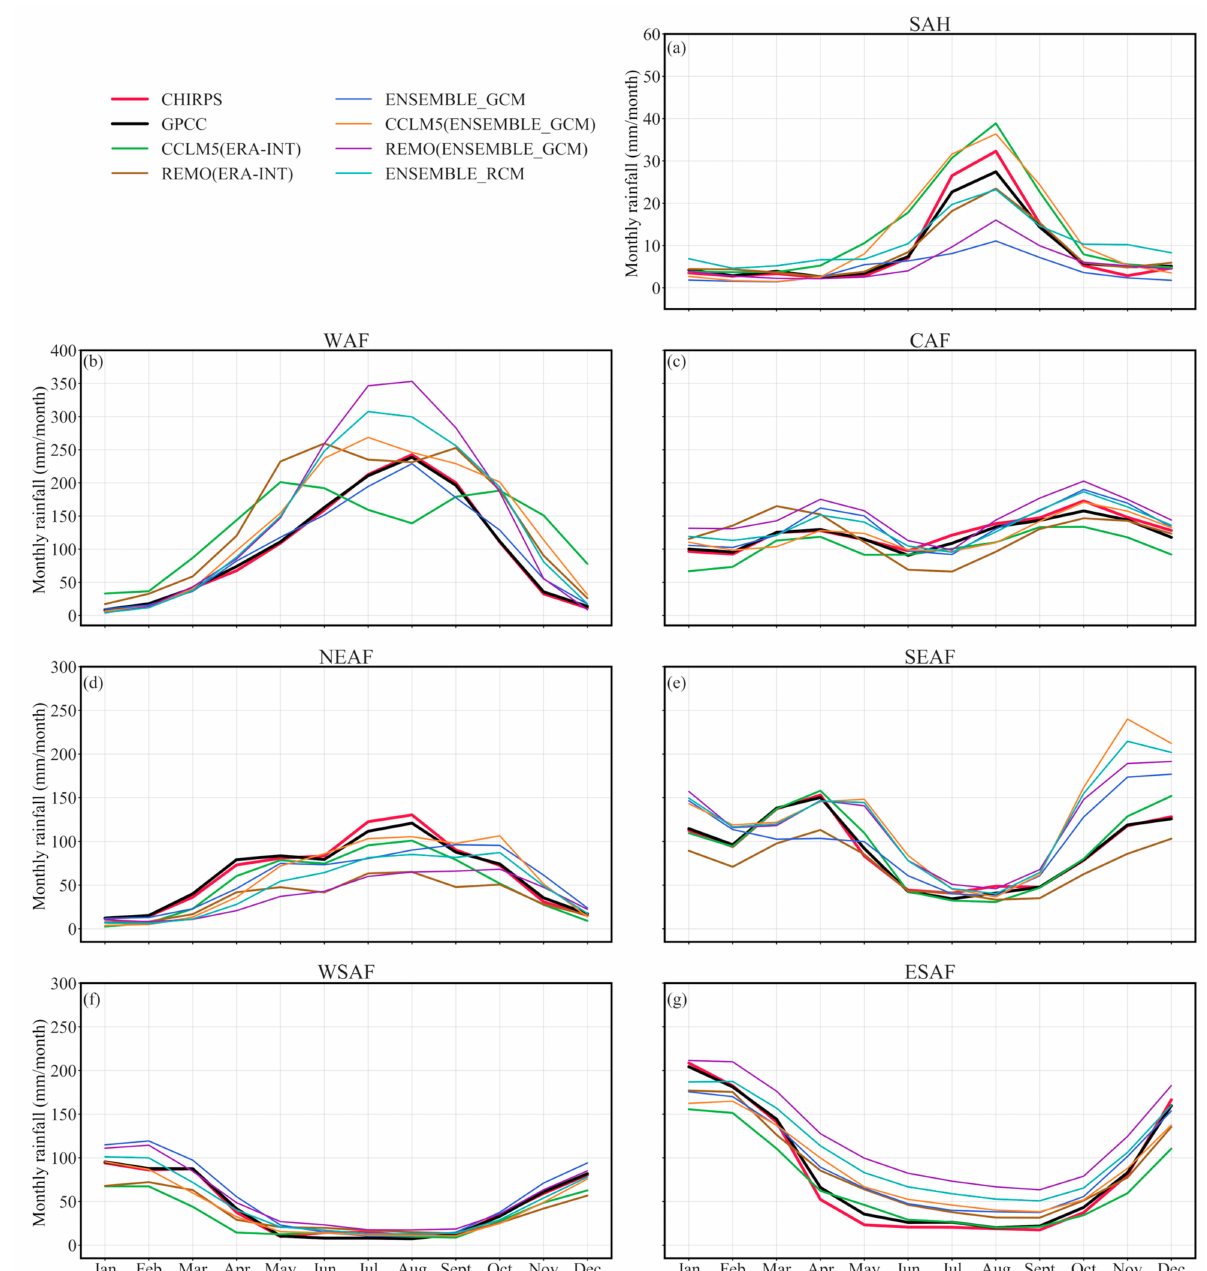
Figure 6. Annual cycles of mean monthly precipitation (mm/month) over the regions indicated in Figure 1: ( a ) Sahara (SAH) region, ( b ) West Africa (WAF) region, ( c ) Central Africa (CAF) region, ( d ) Northern East Africa (NEAF), ( e ) Southern East Africa (SEAF), ( f ) Western South Africa, ( g ) Eastern South Africa